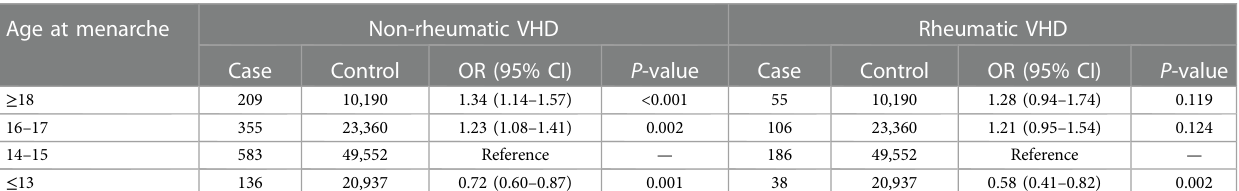
TABLE 2 Analysis of different etiological